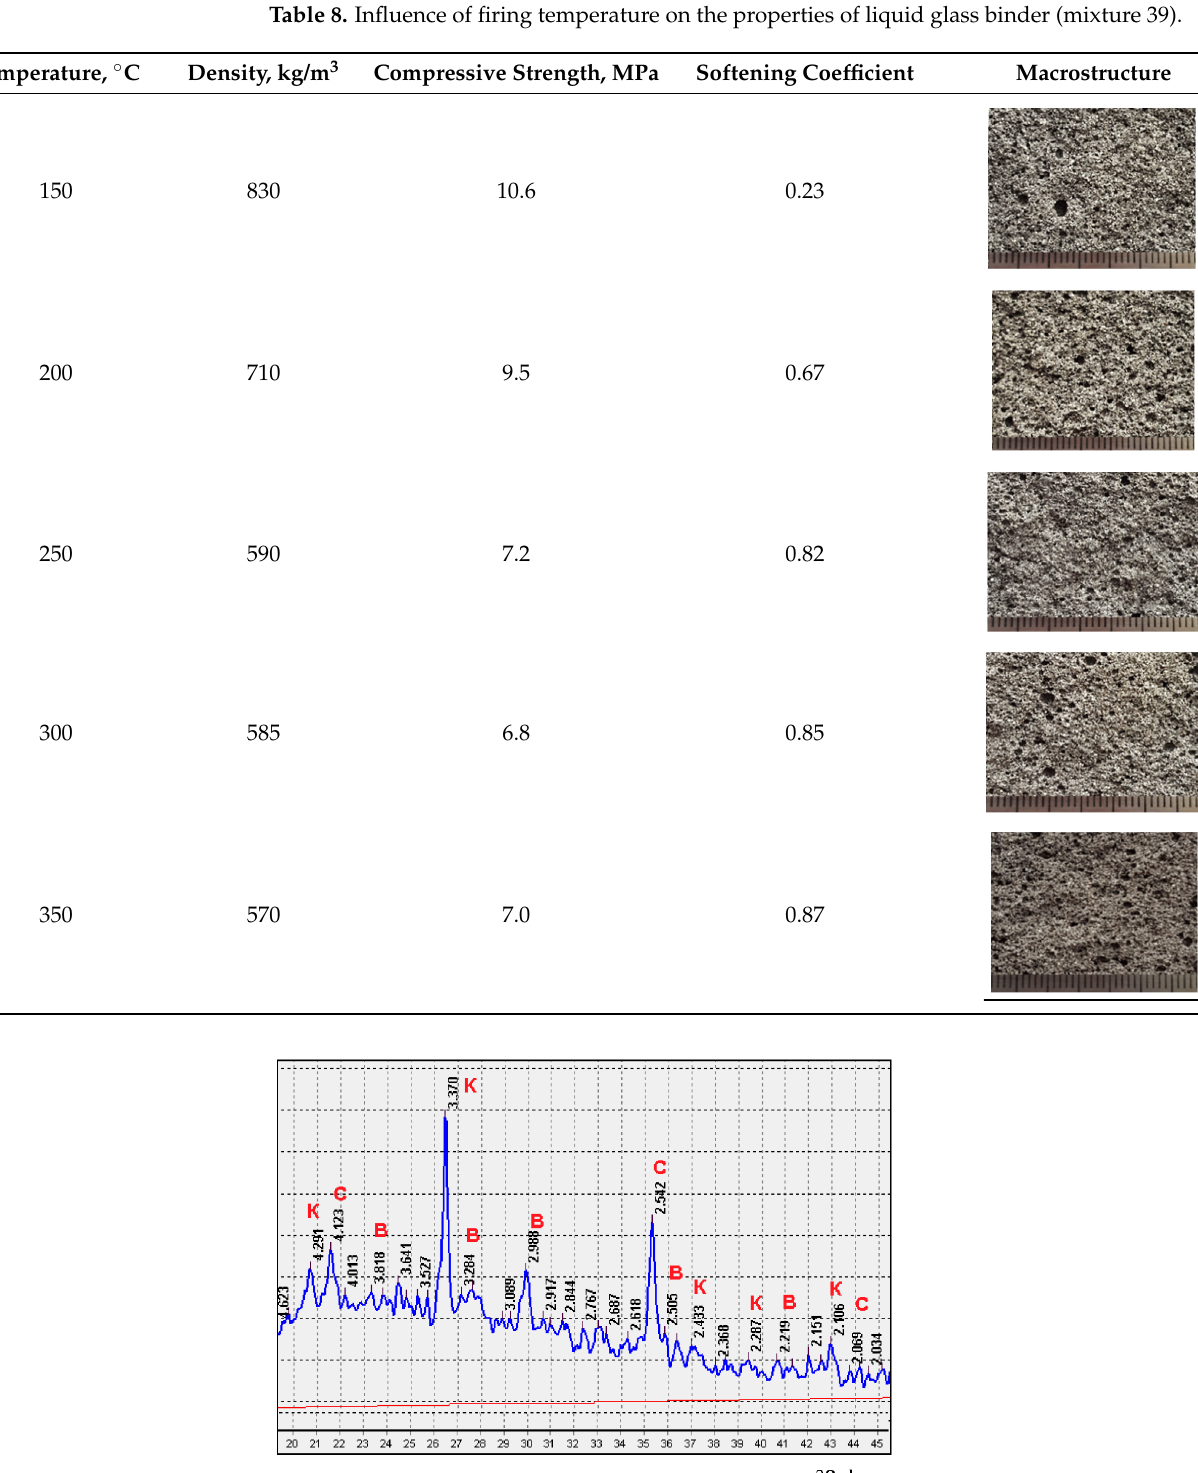
Figure 10. X-ray diffraction pattern of the liquid glass binder, fired at temperature of 350 °C: K— β - quartz; С — α -cristobalite; B—wollastonite.